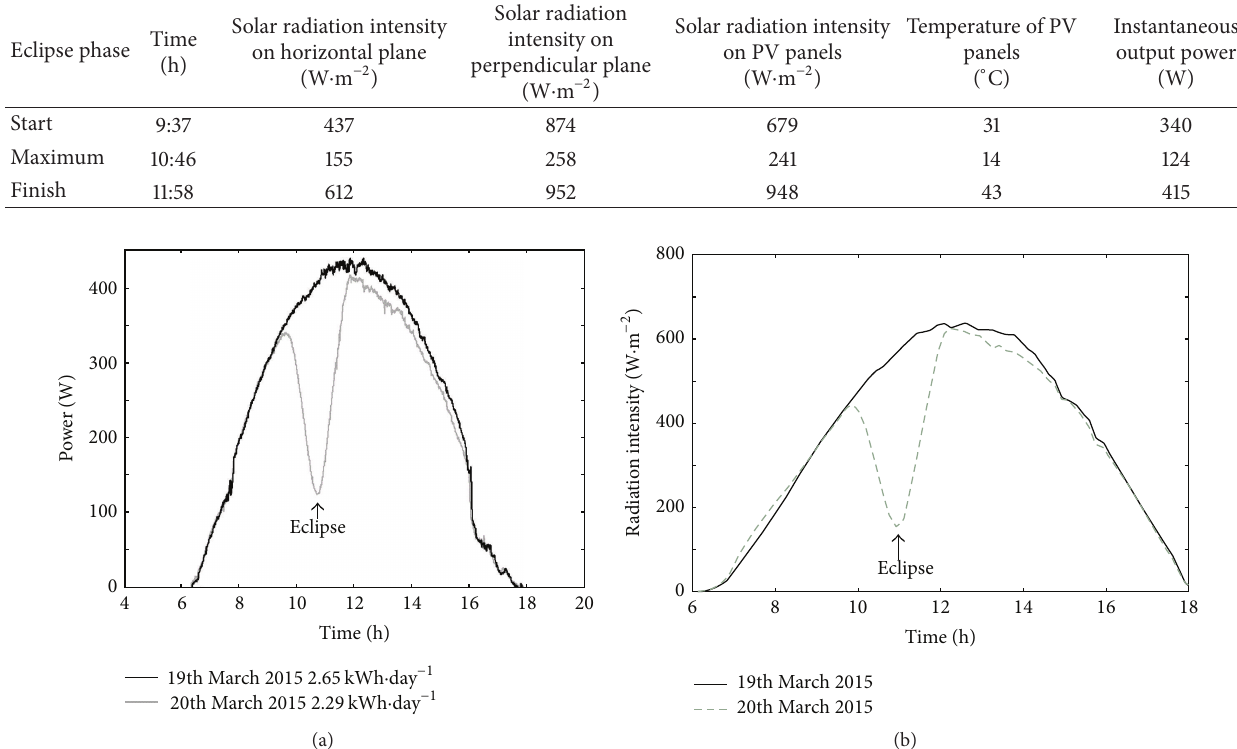
Table 2: Selected values of important variables during the solar eclipse on March 20, 2015.